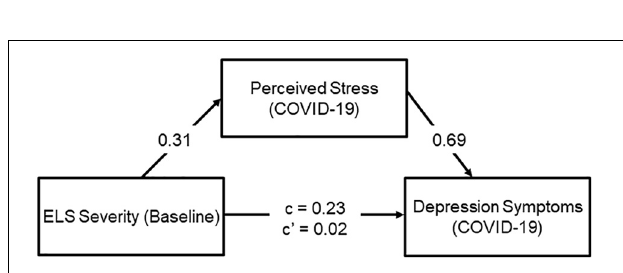
FIGURE 4 | Perceived stress significantly mediates the association between ELS and depression at the COVID-19 assessment. Covariates in this analysis were age at baseline, CDI-S scores at baseline, sex, race, parental income, and age at the COVID-19 assessment. All variables were z